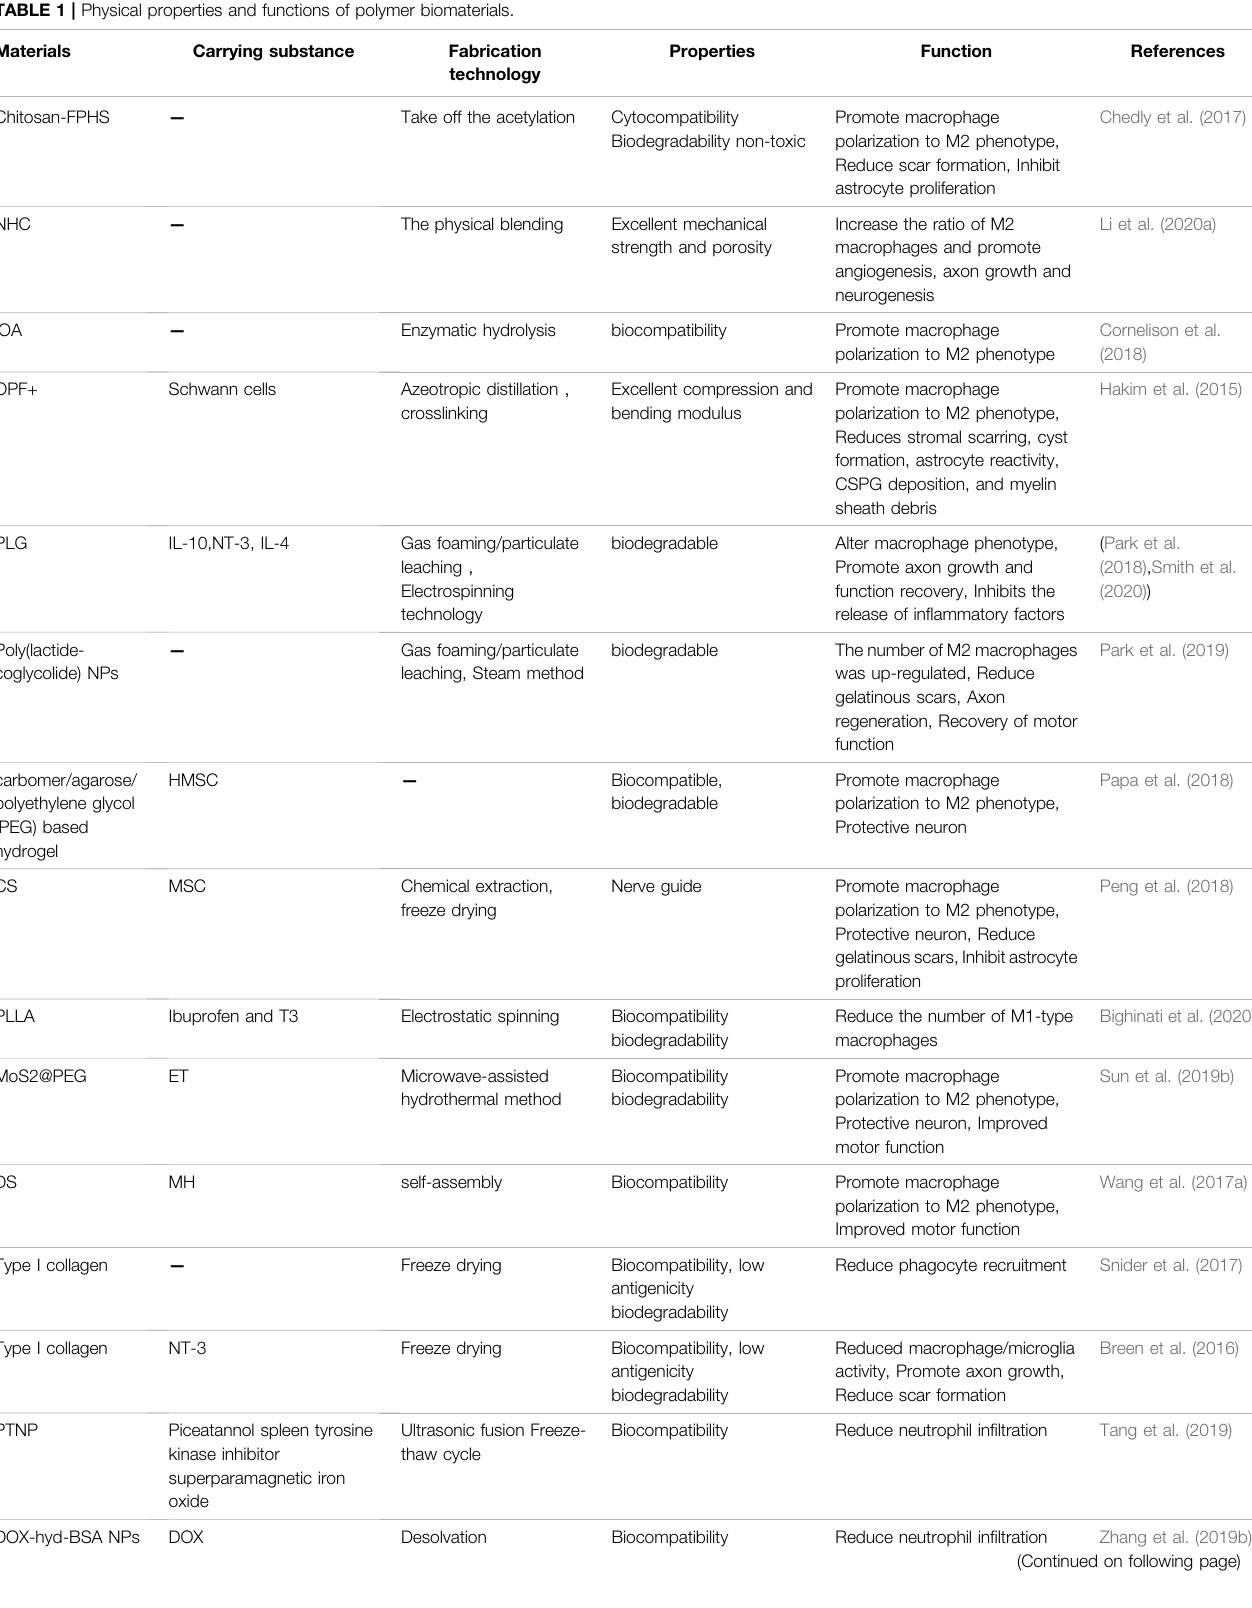
TABLE 1 | Physical properties and functions of polymer biomaterials.